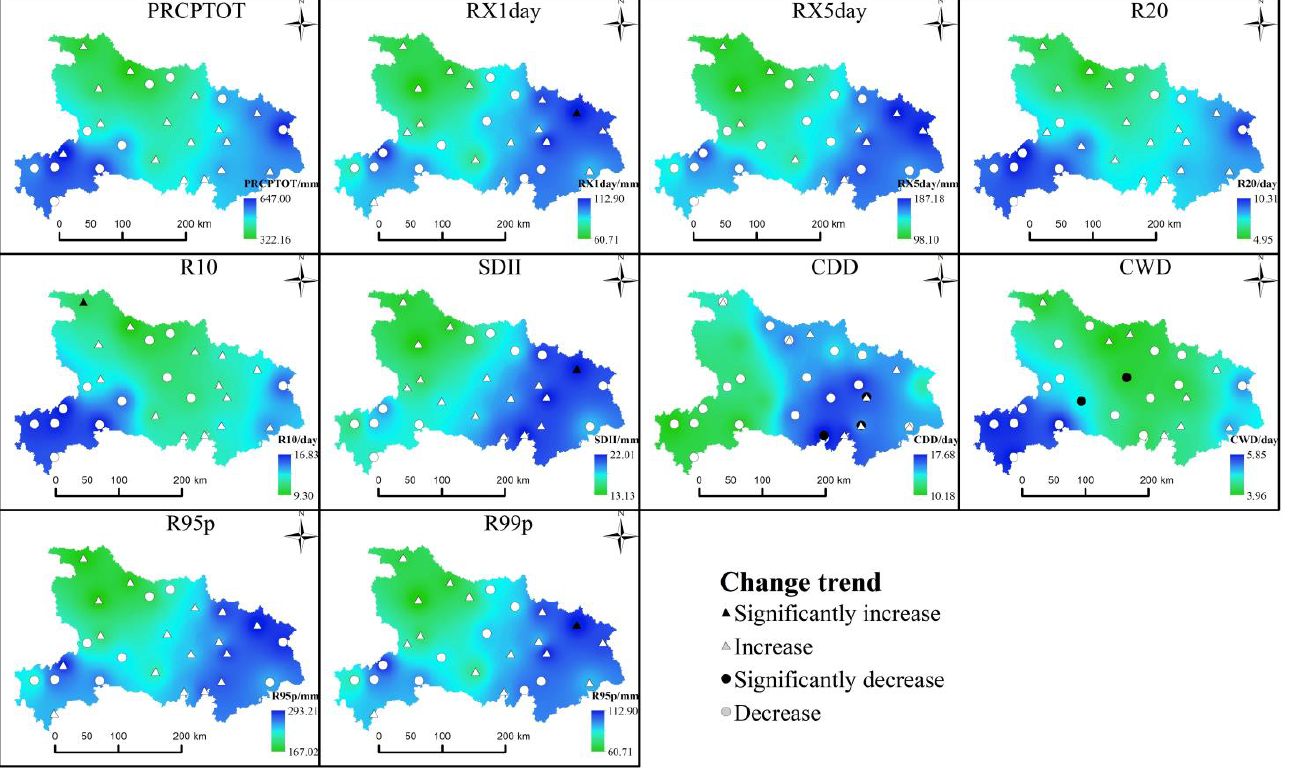
Figure 10. Spatial variations of summer average EPIs and the changing trend of spring EPIs for each station within Hubei province.